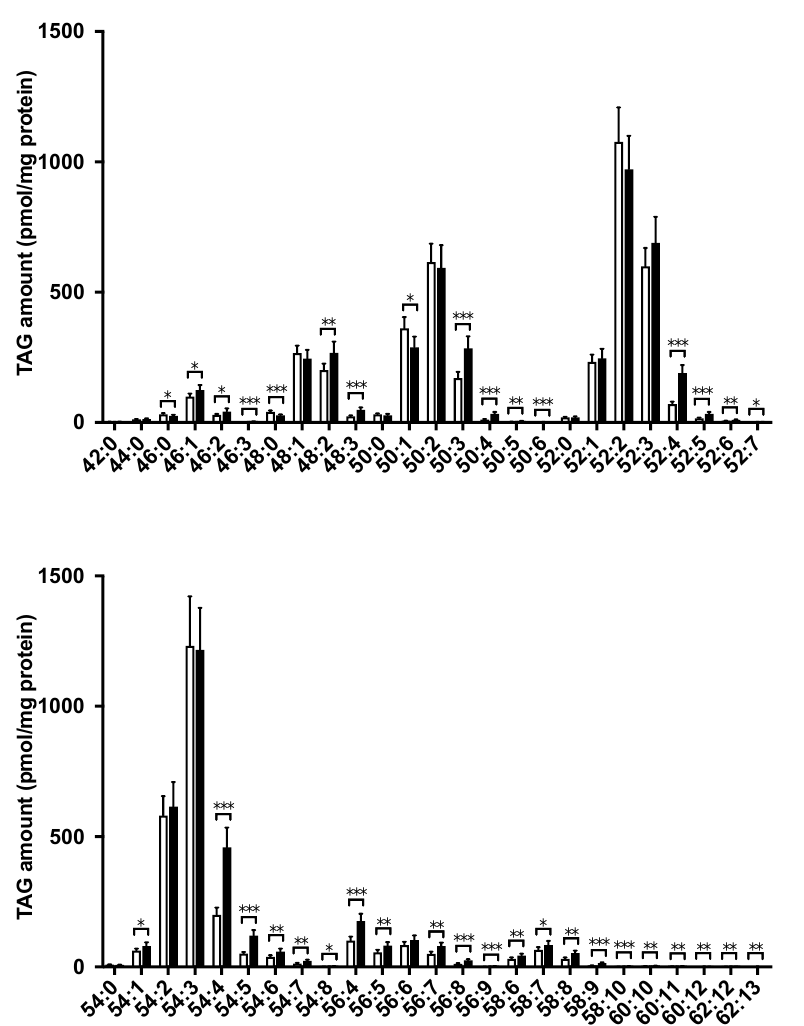
Figure 3. Comparison of TAG species in the lysoPE-supplemented (black bars) and unsupple- mented (white bars) C3A cells detected using Orbitrap LC-MS/MS. Results are shown as mean ± standard deviation. n = 6. Student’s t -test, * p < 0.05, ** p < 0.01, *** p < 0.001. Four molecular CE species were also detected. CE 18:2 was significantly increased in the lysoPE 18:2-supplemented group ( p < 0.05). However, there were no obvious differ- ences in other CE species among the groups (Figure 4).